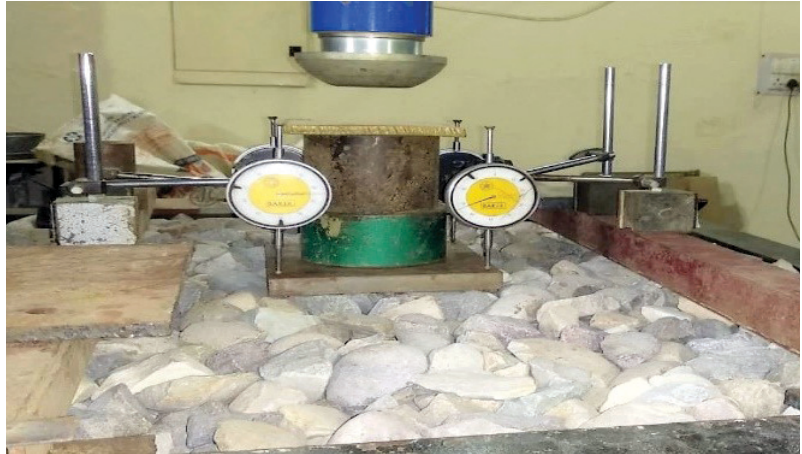
Figure 2. The test setup used in the laboratory showing ballast, dial gauges and loading